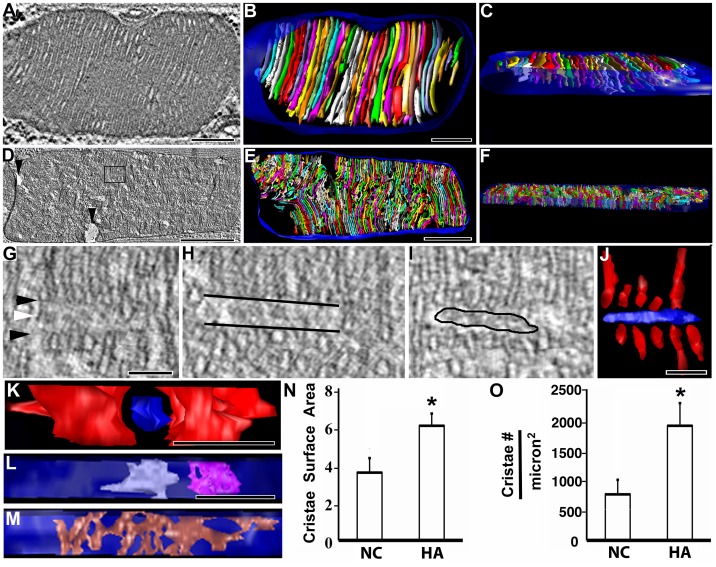
Ultrastructural modifications in the mitochondria of HA flies.(A) Slice through a tomographic volume of a normoxic mitochondrion found in thoracic muscle sliced longitudinally. Normal morphology is observed, including stacks of ordered cristae with light intracristal space and darker matrix. Scale  = 200 nm. (B) Segmented volume of the mitochondrial membrane structure. The cristae (various colors) were all found to be lamellar in form, as expected. This mitochondrial volume contained 42 cristae. Scale  = 200 nm. (C) Oblique view of the mitochondrion viewed partially through the outer membrane (blue) made translucent to observe the cristae arrangement. Same scale as B. (D) Slice through a tomographic volume of hypoxic thoracic muscle. This large mitochondrion displays a few regions devoid of cristae (arrowheads) and more notably, small regions where the cristae have been fractured (boxed example and shown expanded in G-I). Scale  = 1000 nm. (E) Top view of the membrane segmentation of the volume. This mitochondrial volume contained 641 cristae. Scale  = 1000 nm. (F) Oblique view of the mitochondrion viewed partially through the outer membrane to observe the cristae motif. Same scale as E. (G) Expanded view of the boxed region in D. This area and others in (H) and (I) from different slices of the volume show views of rod-like dense cores between fractured cristae. The edge of the rod is the fracture curve of the cristae (black arrowheads) where the cristae in a localized region fractured almost uniformly (black lines in H) and then the ends annealed, i.e., the cristae membrane closed around the break. The dense core (white arrowhead) appears to be the degenerated cristae (black outline in I) that are separated by a white (translucent) band from the annealed cristae membrane curve. Scale  = 100 nm. (J) Top view of the segmented region of I showing the dense core (blue) surrounded by the cristae fragments (red). Scale  = 100 nm. (K) Side view perpendicular to the view in J, down the axis of the dense core appearing almost as an avenue with the cristae as spaced sentinels. Scale  = 100 nm. (L) Examples of two lamellar cristae in the hypoxic mitochondrion of panel D. These cristae were not as extensive as those in the control and often exhibited fenestrations (arrowhead). A greater percentage of cristae were similar to the highly branched and severely fenestrated crista shown in (M) (* p<0.01). Scale  = 500 nm. (N) The cristae surface area, normalized to the mitochondrial outer membrane surface area, was significantly greater in the hypoxic thoracic muscle as was the cristae number, normalized to the mitochondrial cross-sectional area (O) (* p<0.01).